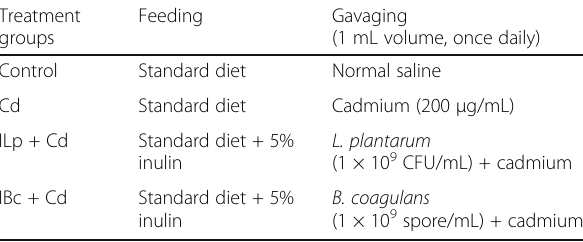
Table 1 Treatment groups used in the experimental study Treatment